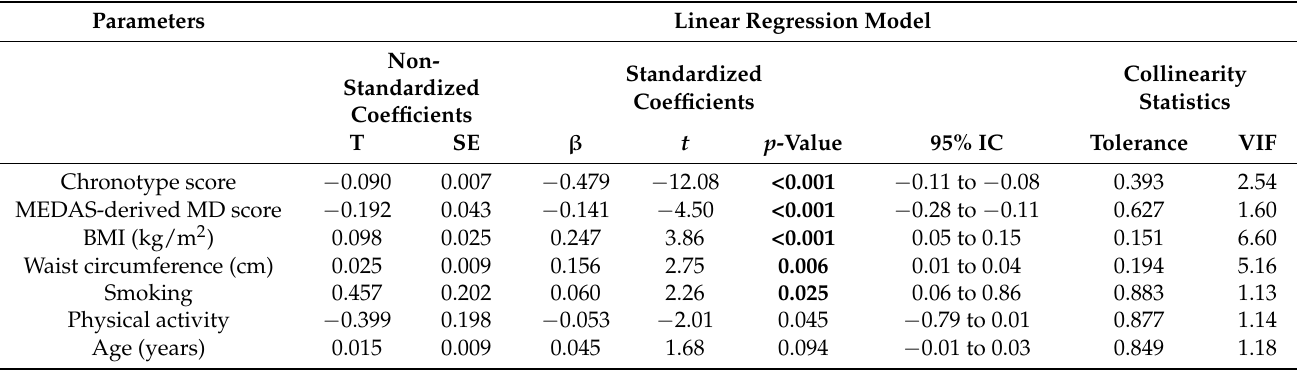
Table 6. Linear regression model for the association between circulating TMAO concentrations and chronotype score, adjusting for potential confounders including age, physical activity, smoking, BMI, MEDAS-derived MD